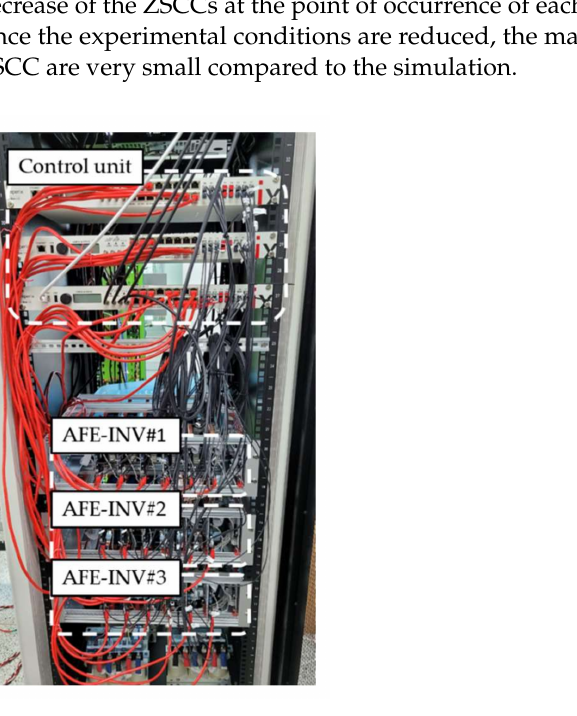
Figure 13. Contracted parallel inverter experimental set.